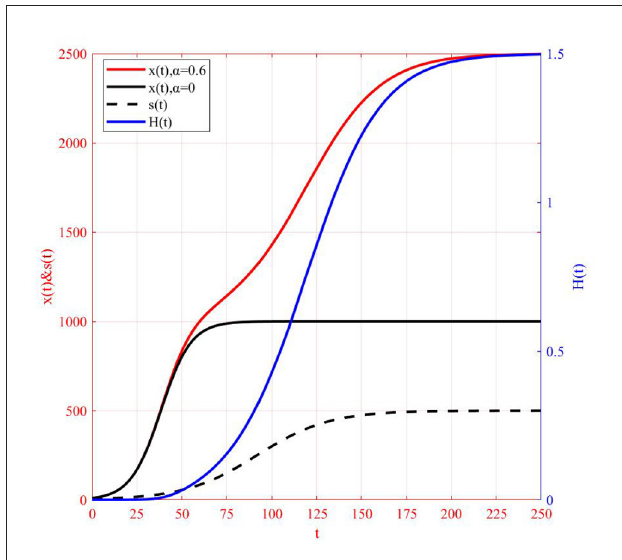
FIGURE5 Comparison of model solution x ( t ) and H ( t ) .